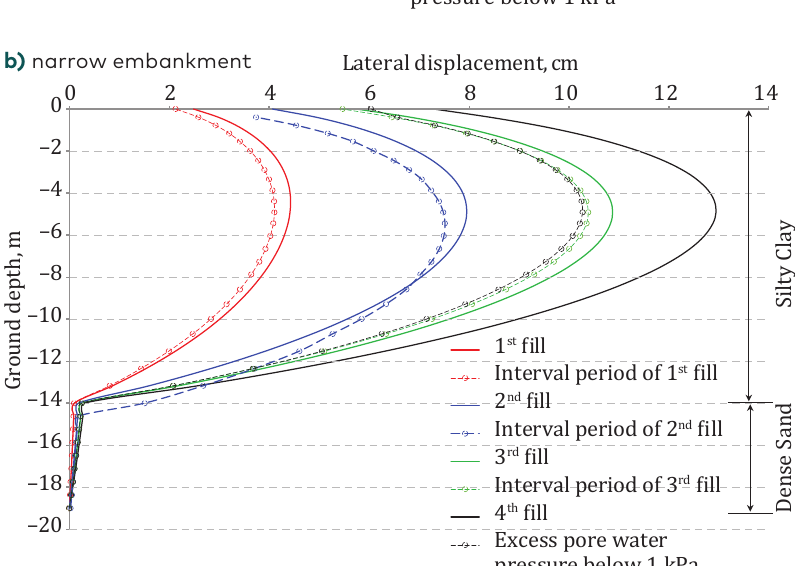
Figure 8. Lateral displacement distribution of ground at the foot of embankment